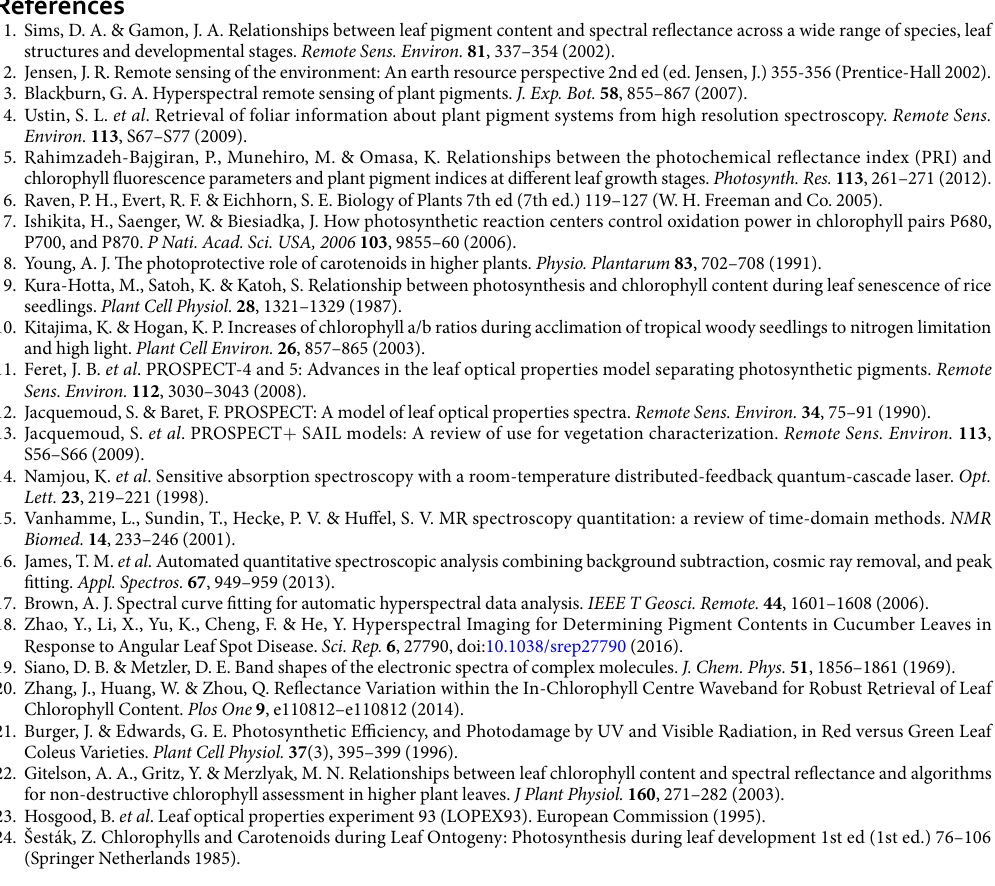
and τ . (leaf trans- la (6)